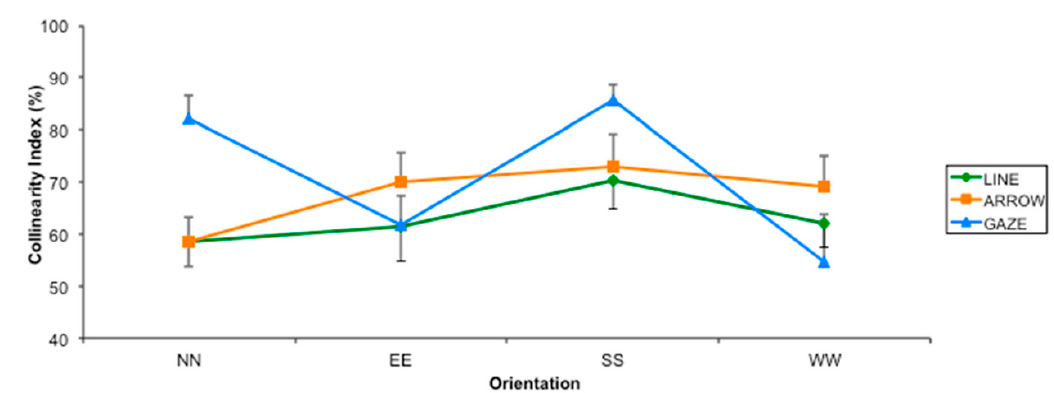
Figure 6. Collinearity Index (indicating the percentage of responses towards the collinear direction) for the three types of stimuli as a function of the four principal orientations (i.e., vertical, NN and SS, and horizontal, EE and WW) in Experiment 1. Error bars indicate the Standard Error.